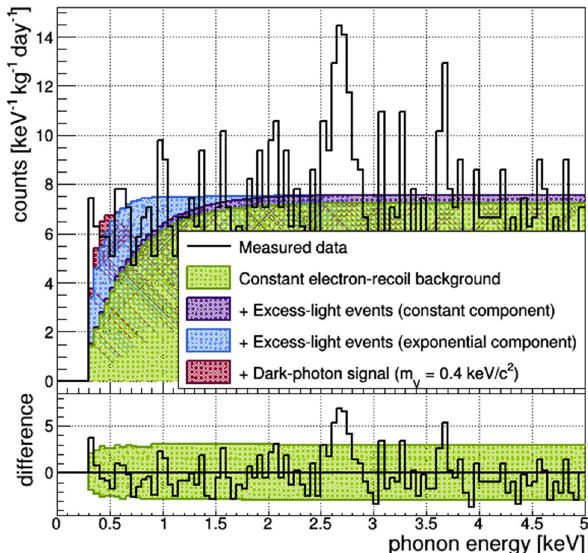
Fig. 4 Top panel Fit results for the phonon energies. In addition to the measured data, the stacked contributions of all components are shown. The fixed mean of the signal peak was set to 0.4keV. The drop in the models below 2keV is related to the decreasing signal-survival prob- ability. Bottom panel The differences between the data and the fitted model in each bin are depicted as solid black line . In addition, the sta- tistical uncertainties (central 90% region) of the fitted model are shown as green-shaded region